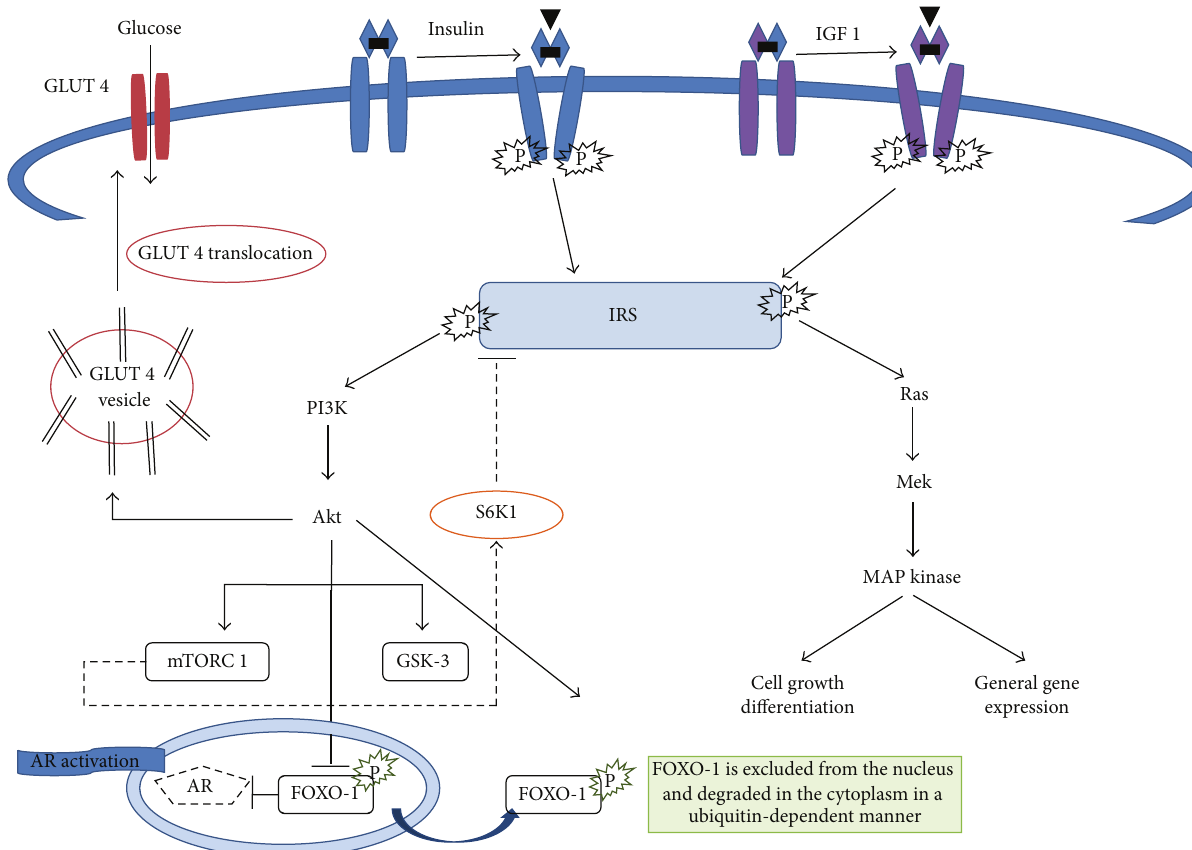
Figure 1: Insulin signalling pathway: insulin binds to the insulin receptor leading to its autophosphorylation and recruitment of adaptor molecules such as insulin receptor substrates (IRS 1–6) to engage multiple downstream signalling pathways. IRS activation can be also triggered by IGF-1 signalling. Phosphoinositide 3-kinase (PI3-K)/Akt, mammalian target of rapamycin (mTOR), and the Ras/mitogen- activated protein kinase (MAPK) pathways represent the major cellular signalling pathways activated. Particularly, AKT controls the assembly of glucose transporter- (GLUT-) 4 at the cell membrane and thus controls glucose influx into the cell. mTOR complex 1 (mTORC1) activates the kinase S6K1, which phosphorylates and inhibits IRS and thus reduces AKT-GLUT-dependent glucose uptake, the principal mechanism of peripheral insulin resistance. AKT phosphorylation pathway inhibits FOXO-1 mediated gene expression by its extrusion from the nucleus to the cytoplasm, preventing FOXO-1 mediated repression of androgen receptors. GSK-3 = glycogen synthase kinase 3 and FOXO-1 = forkhead box protein